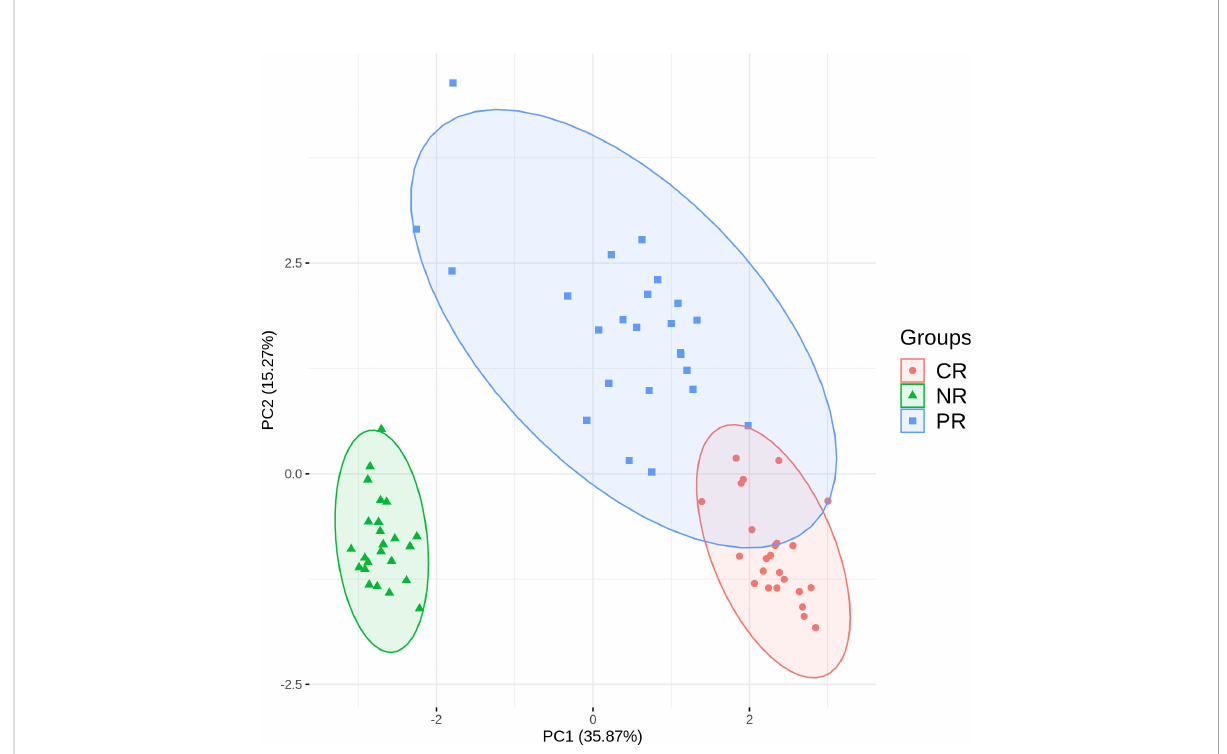
FIGURE 5 Principal component analysis based on J gene usage in CR, PR, and NR reads.